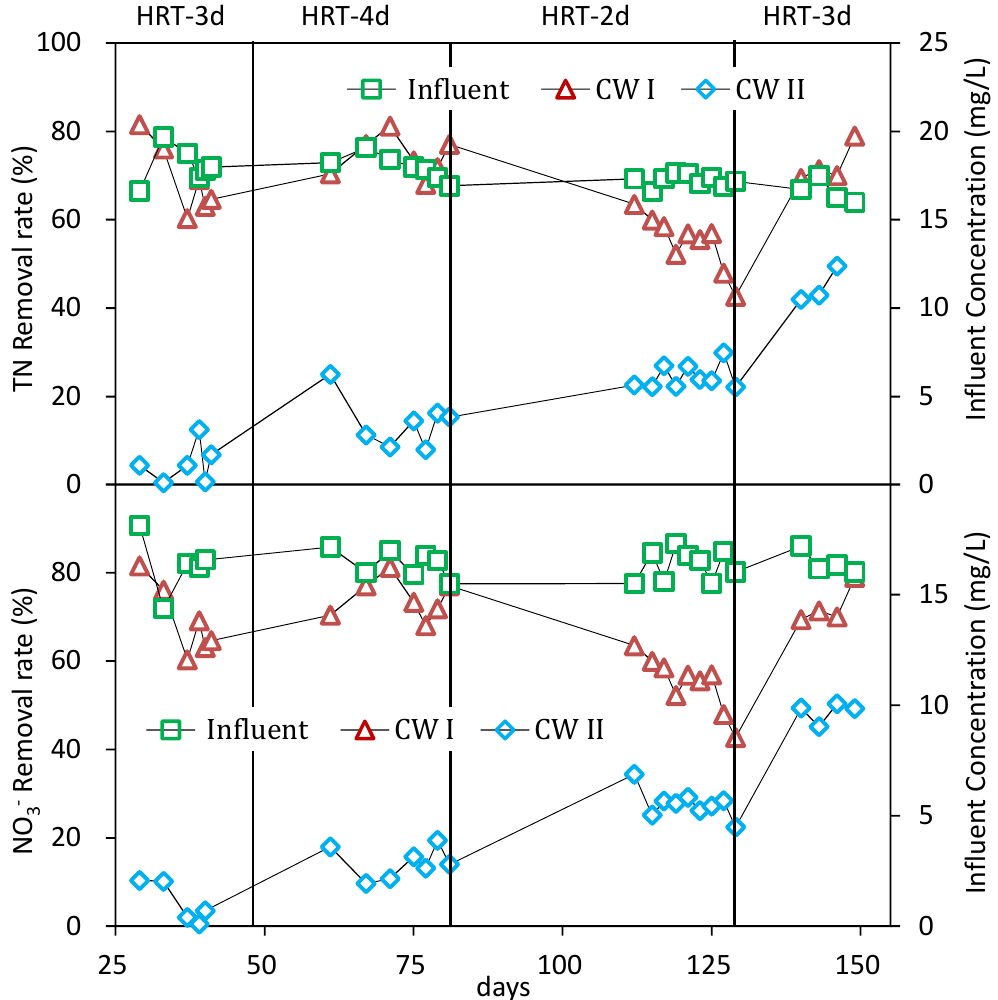
Figure 3. The influent concentration and removal efficiency of TN ( upper) and NO 3− ( bottom ) in the second stage.